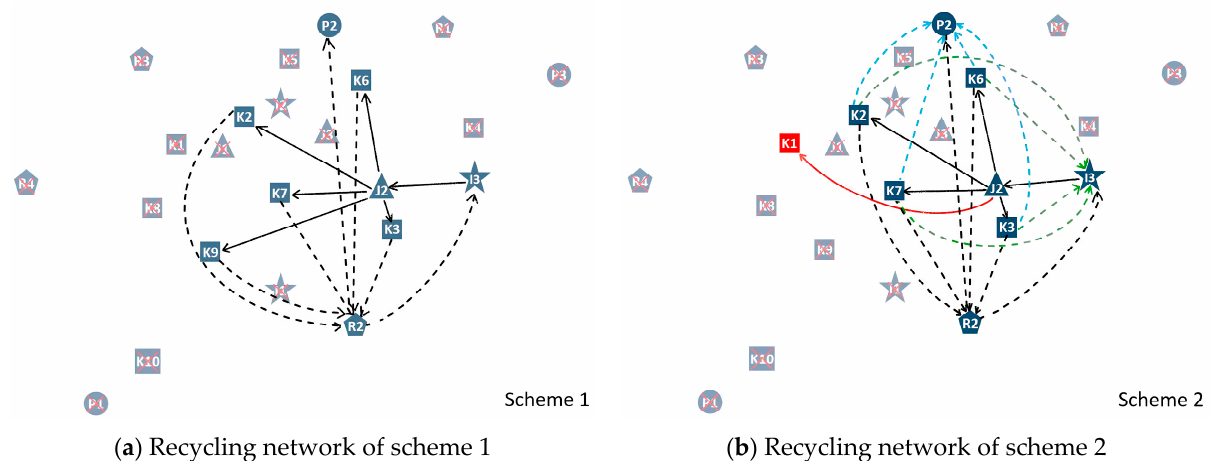
Figure 5. Distribution of alternative processing centers.